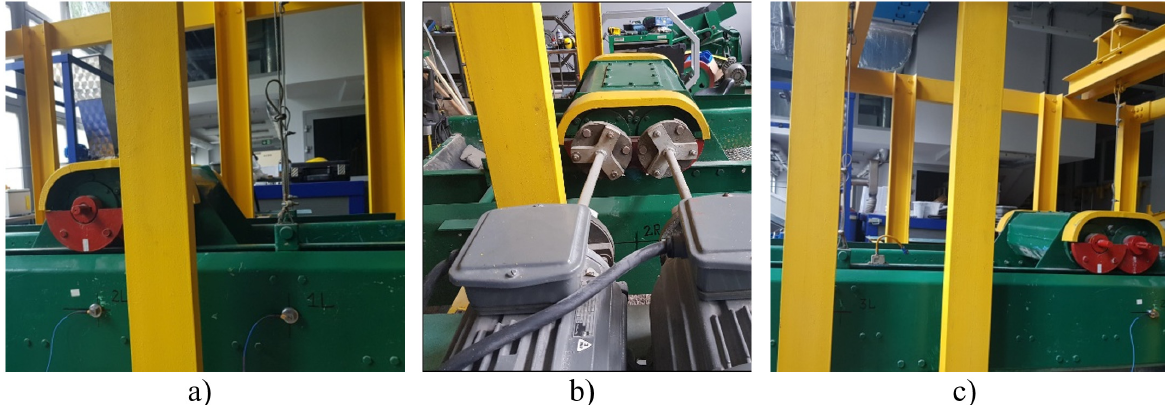
Figure 8. View of selected measurement points marked on the surface of the laboratory WP screen with a classic drive system: ( a ) points 1L and 2L; ( b ) points 2P; ( c ) points 3L and 2L.